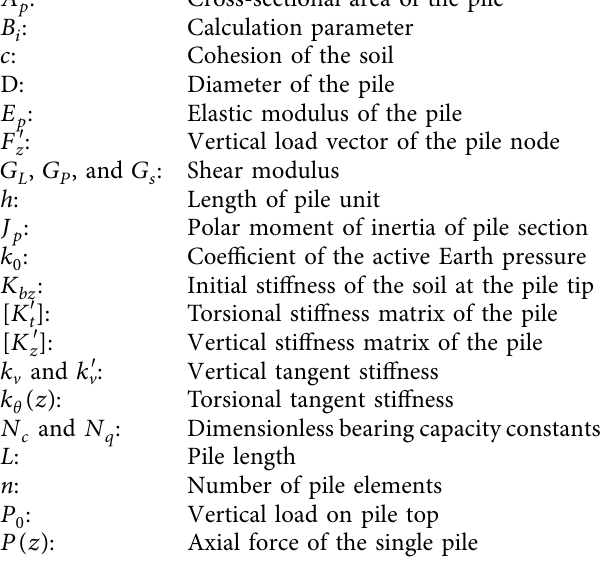
Figure 11: Influence of the pile elastic modulus on the bearing capacity of a single pile. (a) V - w loading path. (b) T- θ curve of a single pile under the V ⟶ T loading t